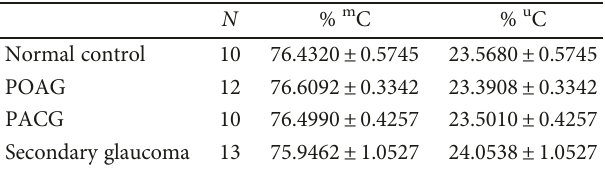
Table 4: HERV-E methylation levels in glaucoma eyes and control eyes. N % m C % u C